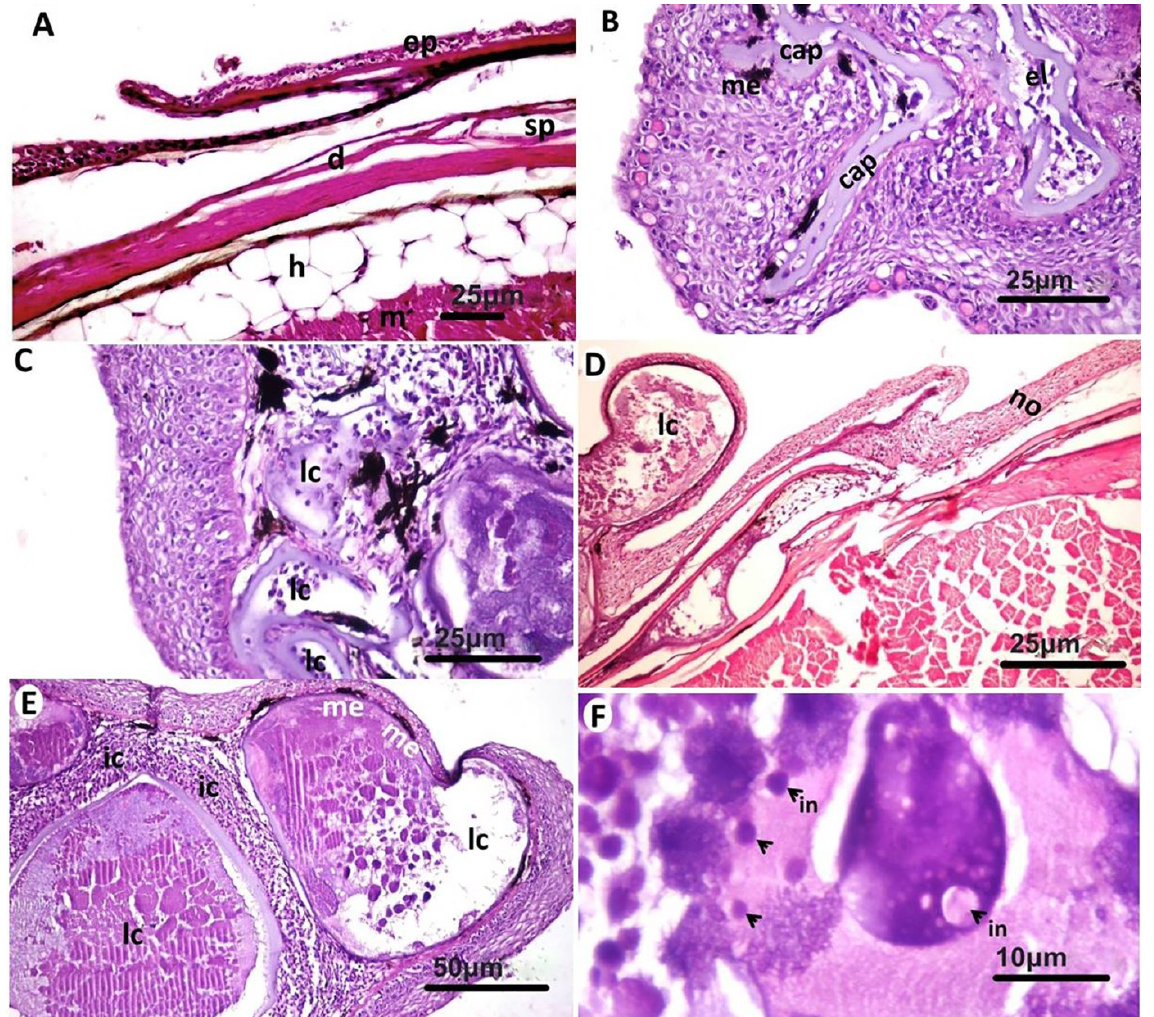
Figure 2. Microscopic pathological examination of gilthead seabream ( Sparus aurata ) skin. ( A ): Apparently normal skin area with normal epidermis (ep), dermis (d), scale pocket (sp), hypodermis (h), and muscle layer (m). ( B ): Early lymphocystis lesion (el) containing small numbers of fibroblastic cells and surrounded with thick basophilic capsule (cap) and melanophores (me). ( C ): More enlarged lymphocystis lesion (lc) with thin capsule containing many fibroblastic cells. ( D ): Severely enlarged lymphocystis lesion (lc) protruded over the skin, while other parts of the skin were apparently normal (no). ( E ): Lymphocystis cells (lc) containing basophilic tissue debris and edematous fluid without prominent fibroblastic cells. The cysts were surrounded by inflammatory cells (ic). ( F ): Basophilic and eosinophilic inclusion bodies (in) in lymphocystis cells. (H&E).